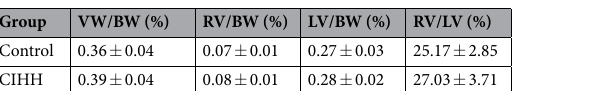
Group VW/BW (%) RV/BW (%) LV/BW (%) RV/LV (%) Control 0.36 ± 0.04